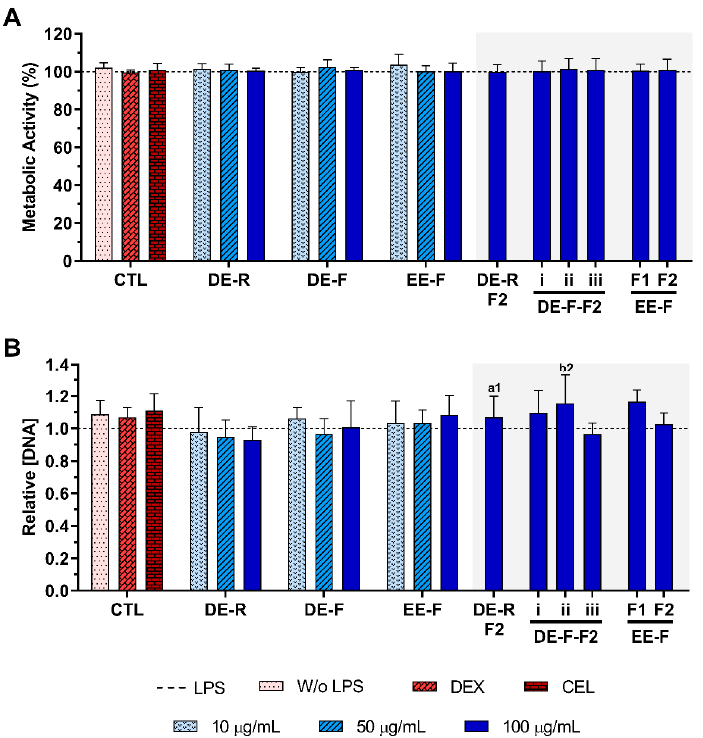
Figure 4. Metabolic activity ( A ) and relative DNA concentration ( B ) of LPS-stimulated human monocyte-derived macrophages (hMDMs) cultured in the presence of different concentrations of the E. purpurea extracts, fractions, and clinically used anti-inflammatory drugs (dexamethasone (DEX) and celecoxib (CEL), 10 µ M) for 24 h. The dotted line represents the metabolic activity and DNA concentration of positive control (LPS-stimulated hMDM without treatment). There are no statistically significant differences in comparison to the positive control for each tested extract, fraction, DEX, and CEL. Statistically significant differences are 1 ( p < 0.0133) and 2 ( p < 0.0035) in comparison with a (DE ‐ R vs. DE ‐ R ‐ F2) and b (DE ‐ F vs. DE ‐ F ‐ F2) at the same concentration. CTL: control; DE: di ‐